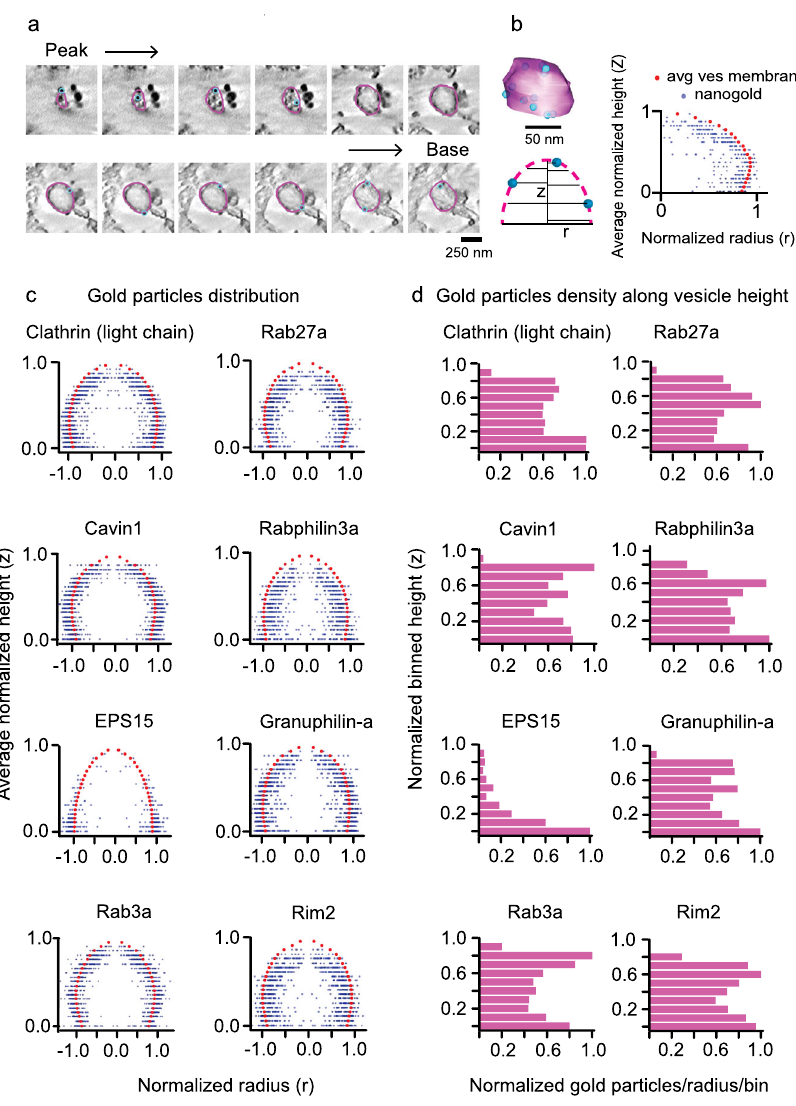
Fig. 5 3D mapping of proteins on vesicles with nanogold. a Tomogram z slices of a single clathrin-coated vesicle from peak to the base of the structure. b 3D model view of the vesicle from contour points for membrane (magenta) and scatter points for gold (blue) particles (upper panel, scale bar = 50 nm). Scheme (lower panel) for obtaining positions for gold particles with respect to vesicle membrane contours. Radius for each contour point (magenta, r ), its height from the base of the vesicle ( Z ), radius for gold particle (blue), and its height. A representative pro fi le on the right showing the distribution of gold particles (blue) with respect to the vesicle membrane (red). c Spatially averaged and normalized distribution pro fi le for clathrin, cavin1, EPS15, Rab3a, Rab27a, Rabphilin3a, Granuphilin-a, and Rim2 on vesicles. The particles are re fl ected across the ordinate. d Density of gold-labeled proteins along the vesicle height (10 bins). The histograms show the sum of particles in each bin (for all vesicles) divided by the average radius of the bin per vesicle. The total number of vesicles collected and analyzed from two independent experiments (for a – d ) are: clathrin light chain A, 54; Cavin1, 63; EPS15, 65; Rab3a,